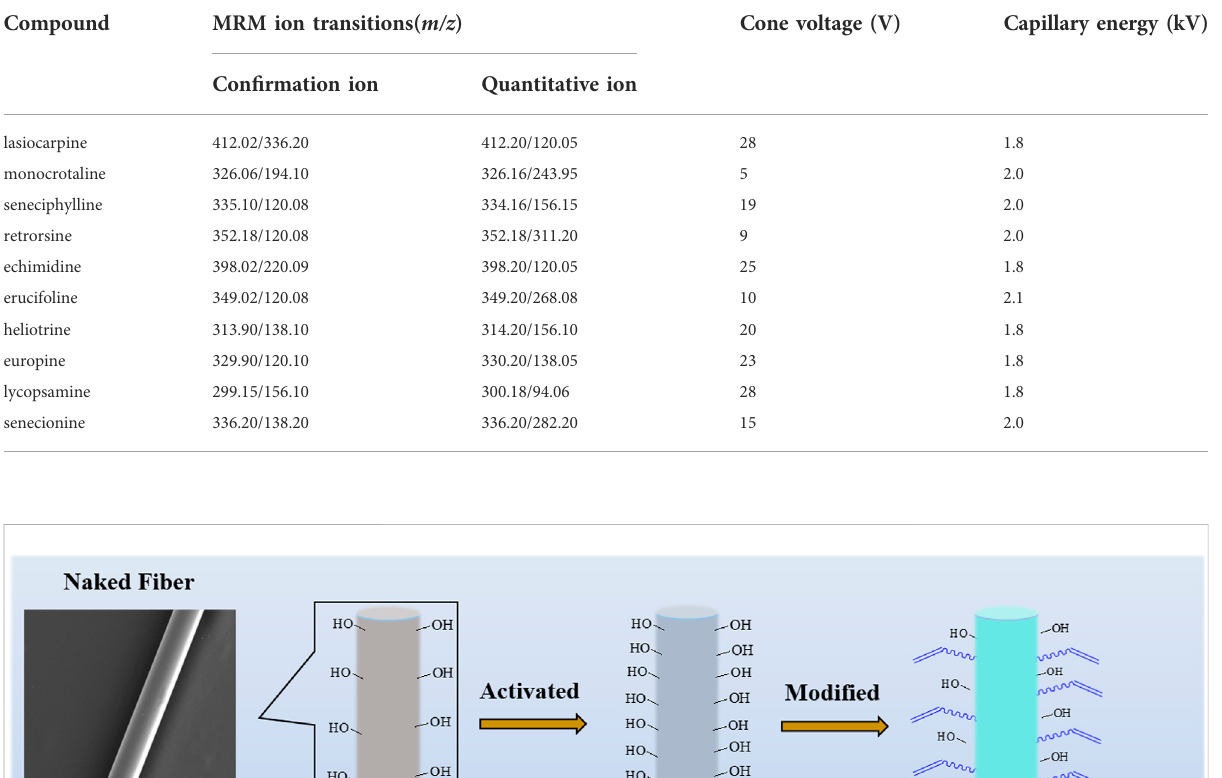
TABLE 1 UPLC-Q-TOF-MS parameters of HPAs.